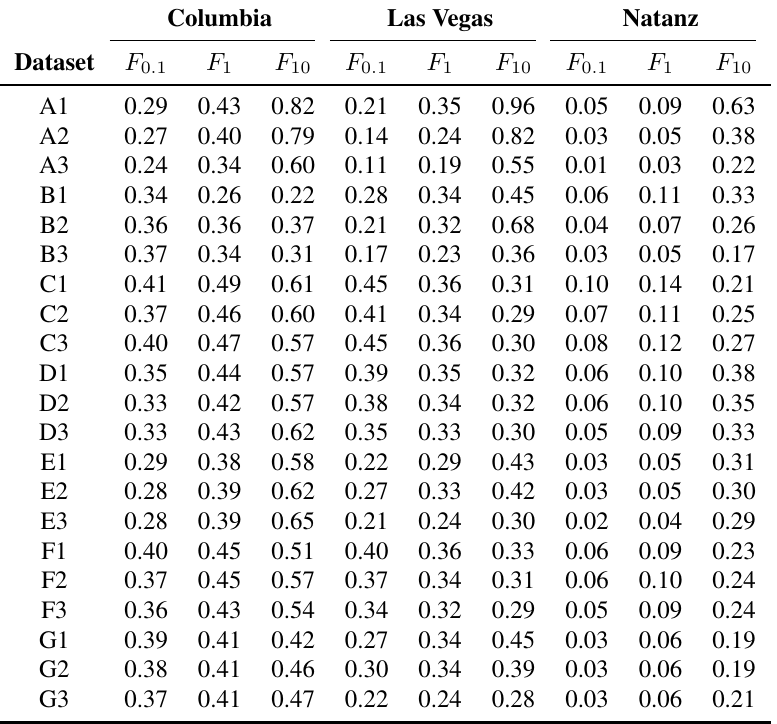
Table 12. Analysis of nearest neighbor change prediction results using a generalized F-Score.